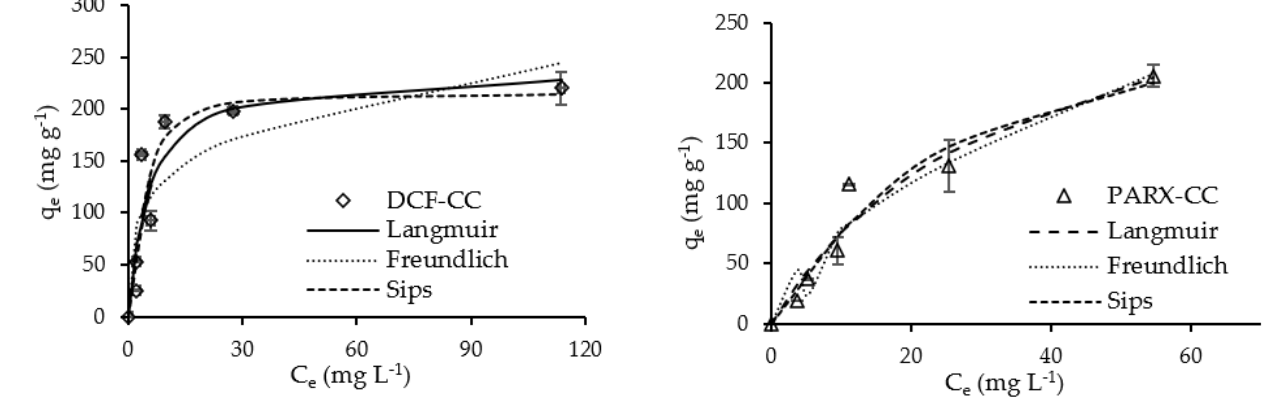
Figure 8. Adsorption equilibrium curves of DCF and PARX for CC carbon (Adsorbent mass = 10 mg; Contact time = 8 h; Solution volume = 25 mL; Solution initial pH = 6.0 (DCF) and 5.5 (PARX)). Dots—experimental data; Lines—isotherm models’ adjustment.